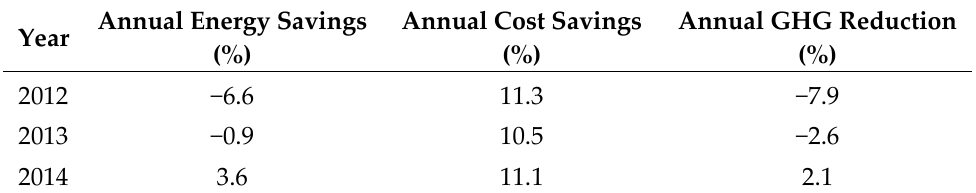
Table 4. Annual energy and cost savings, and reduction in GHG emissions for both heating and cooling